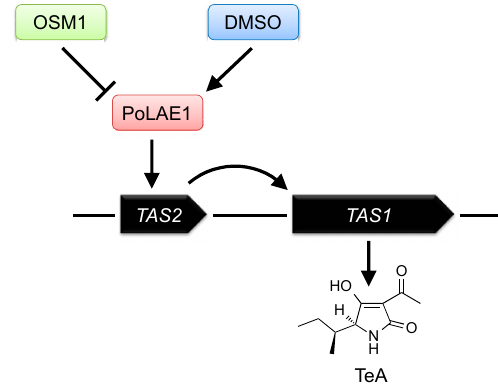
Figure 6. Regulation of TeA production in P. oryzae .